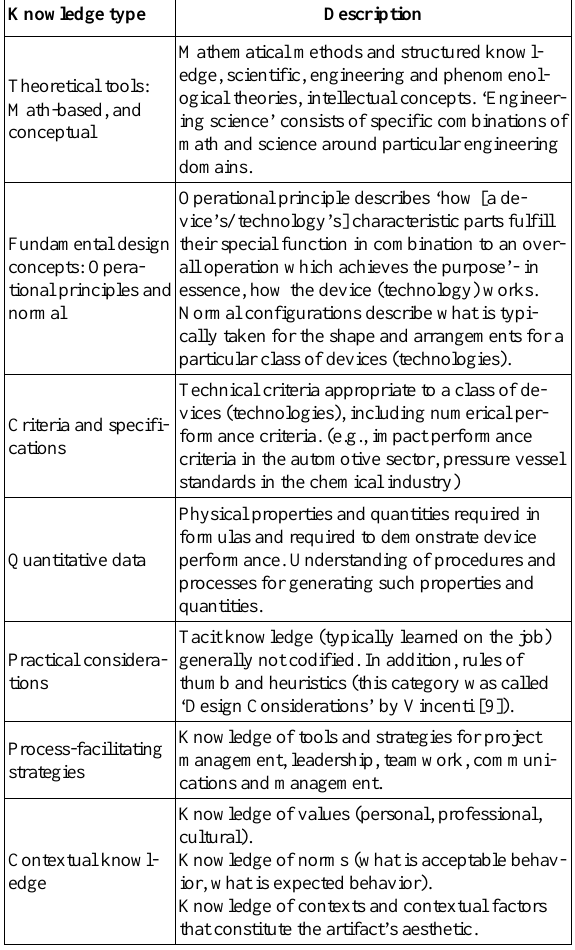
TABLE I. K NOWLEDGE T YPES U SED BY E